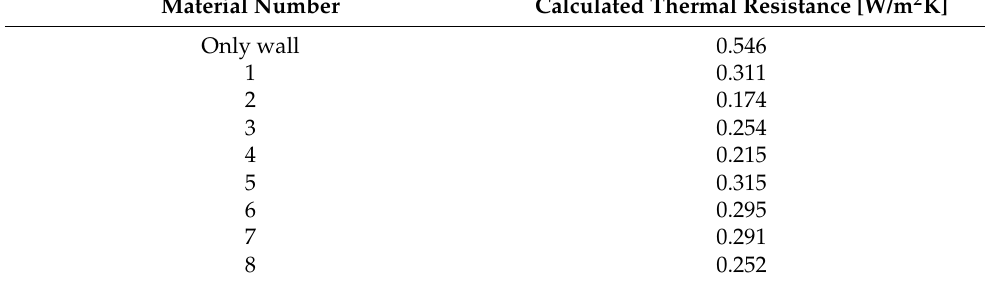
Figure A1. Wall type 1: stratigraphy with thicknesses and conductivities for the different layers. The numbers start from the outside. Table A1. Wall type 1: thermal transmittance reached with different heat-reflective materials.